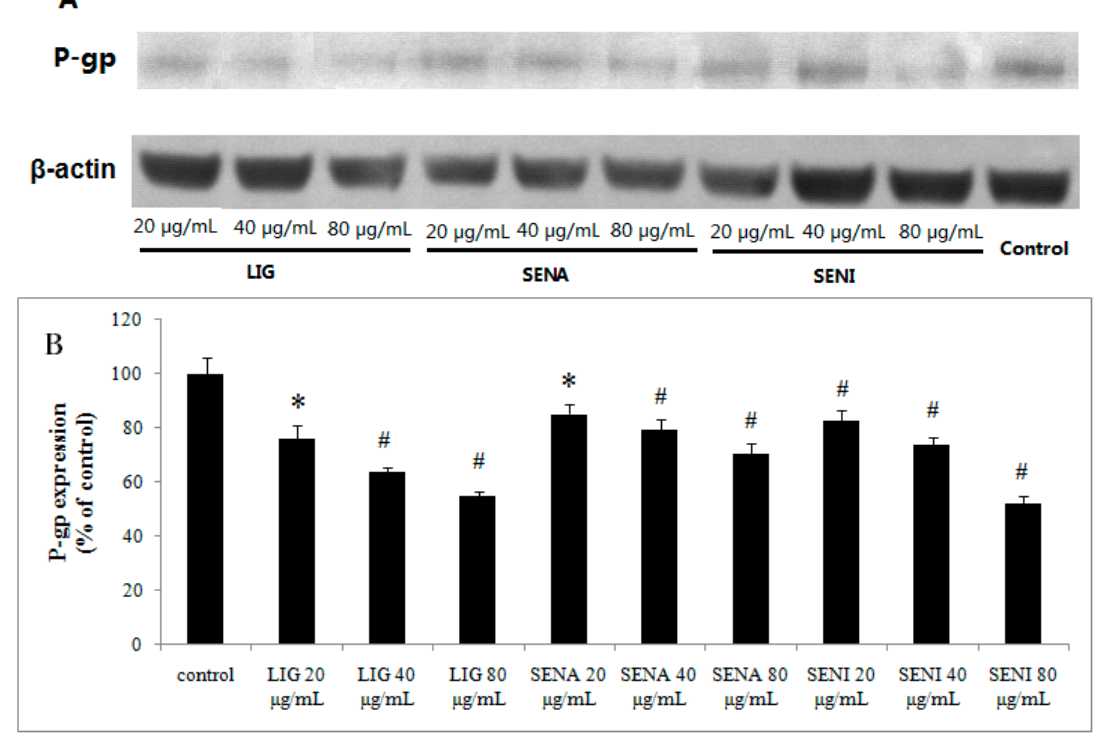
Figure 7. Effects of LIG, SENA and SENI on P-gp expression in MDCK-MDR1 cells: ( A ) representative P-gp expression by Western blot on MDCK-MDR1 treated with different concentration of LIG, SENA and SENI; and ( B ) quantitative data of P-gp expression. Values are mean ± SD ( n = 3). Differs from control group: * p <0.05, # p < 0.01.